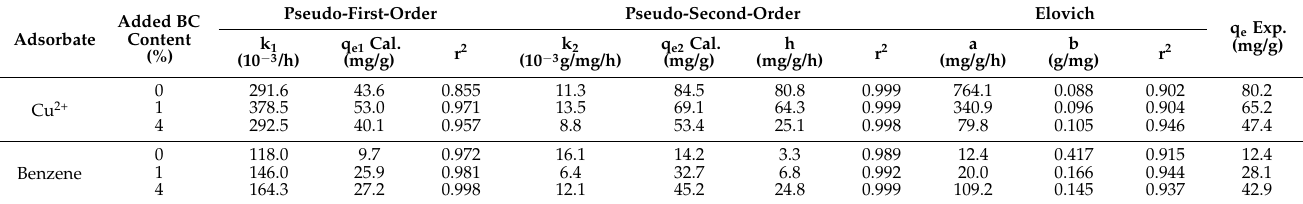
Table 1. Kinetic parameters of Cu 2+ and benzene adsorption onto alginate and alginate/biochar hydrogel beads (1 and 4%